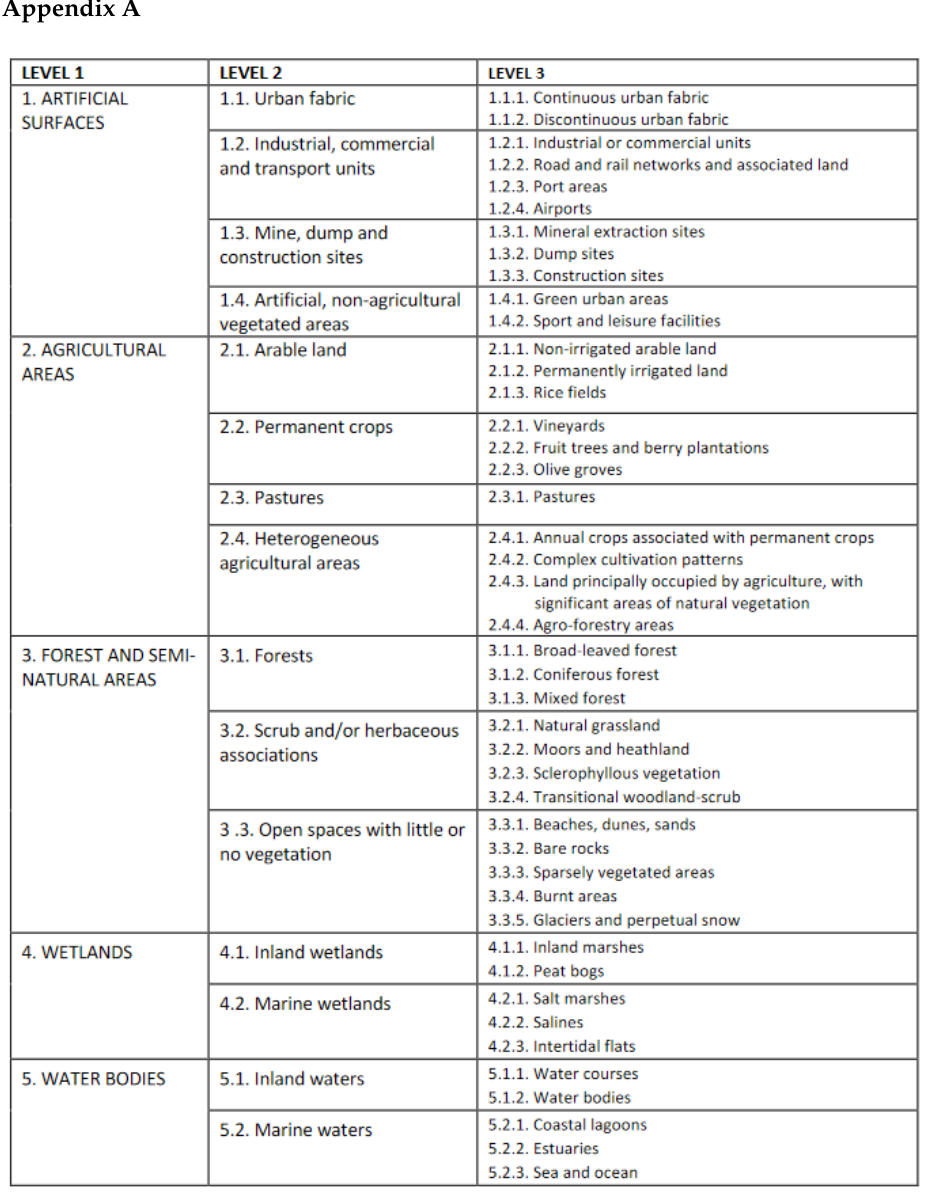
Figure A1. Overview of the three levels of land uses categories of the CORINE land cover data set.